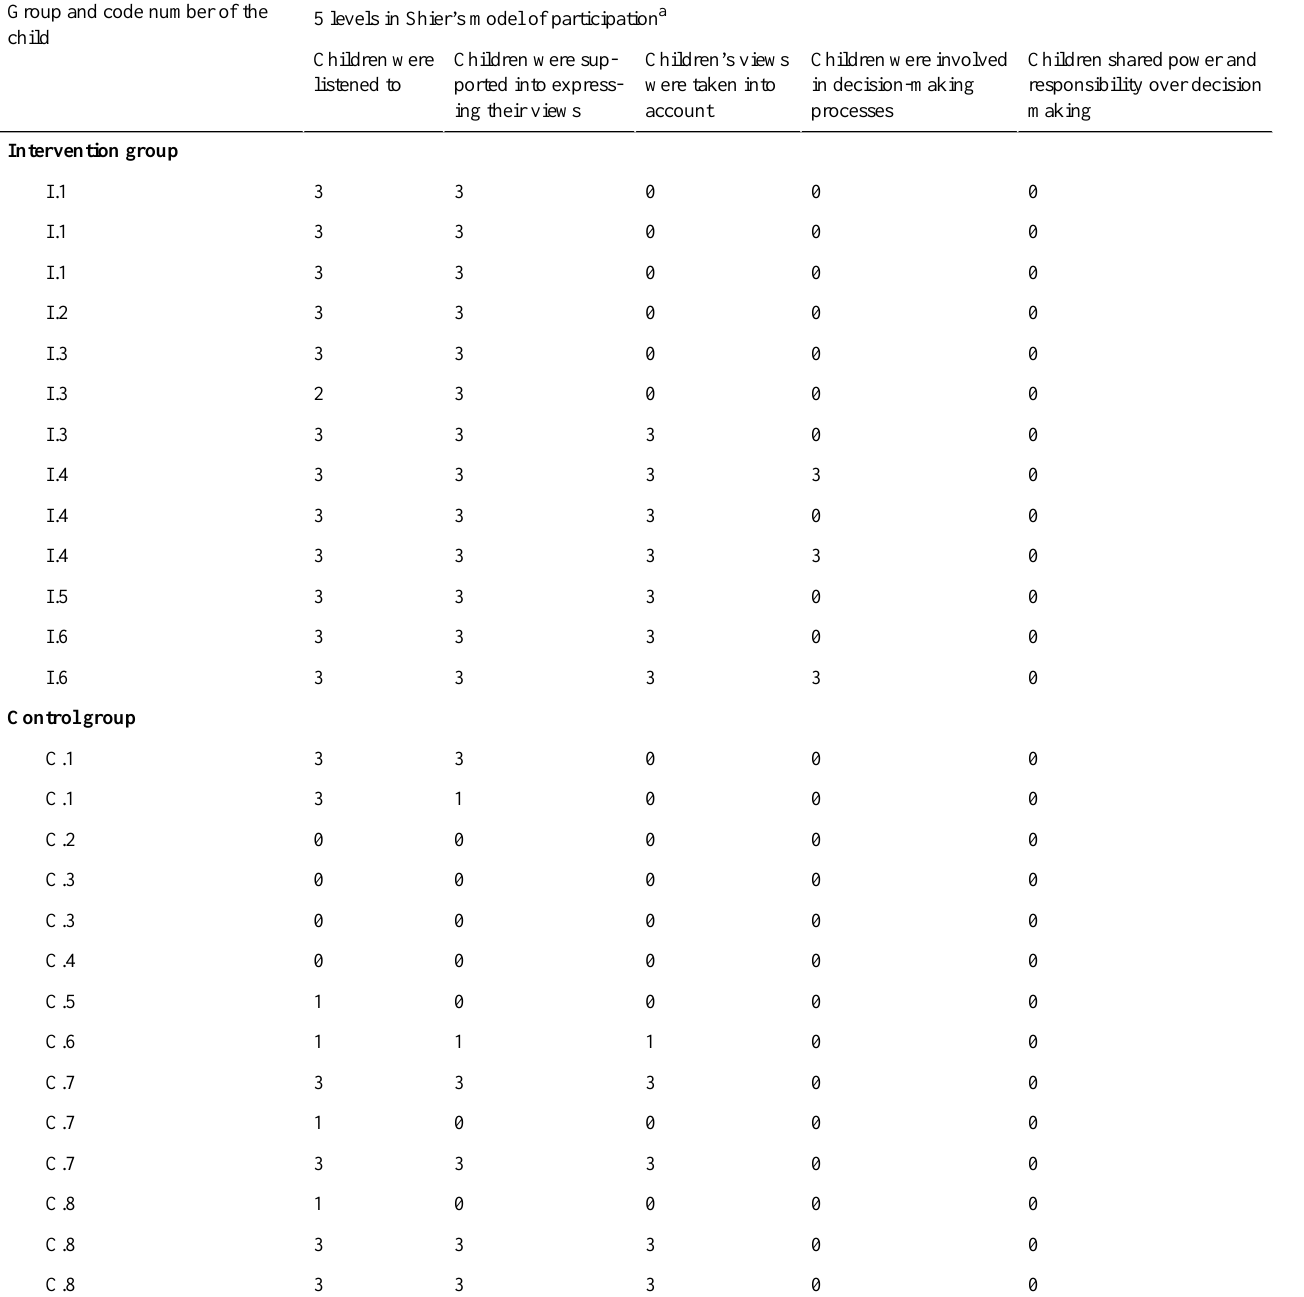
Table 3. The ranges (0-3) of the levels of children’s participation during the appointments with the pediatricians, according to Shier’s model. 5 levels in Shier’s model of participation a Group and code number of the